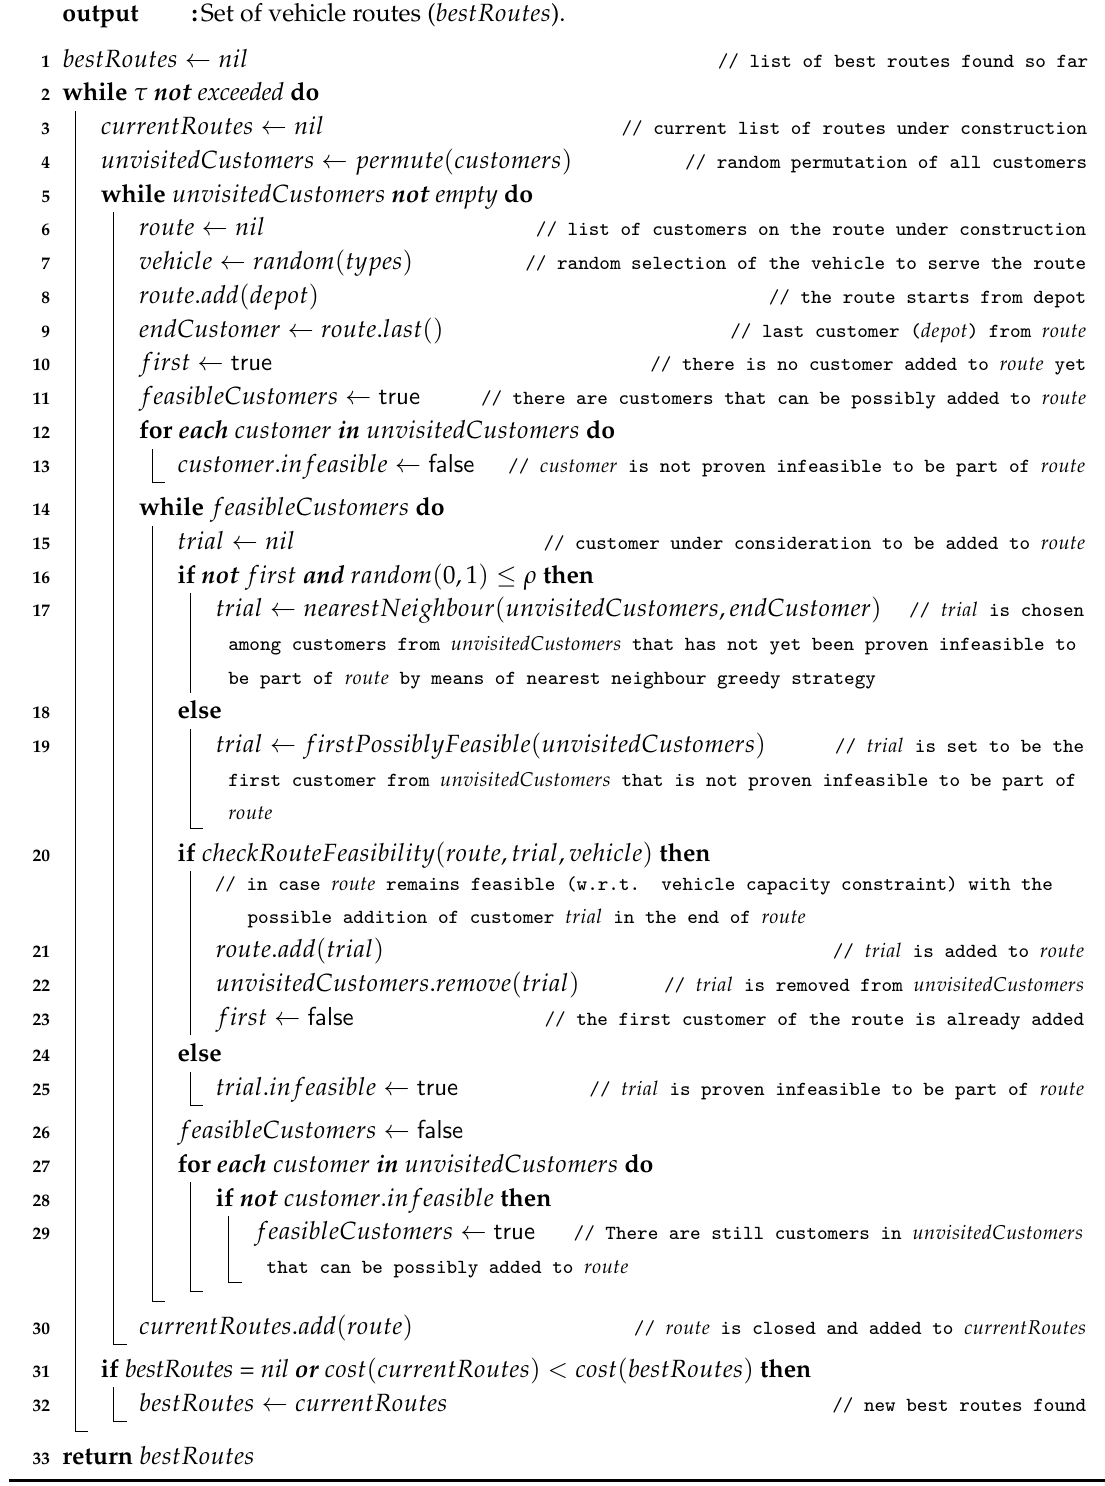
Algorithm 1: Nearest-Neighbor-Based Randomized Algorithm parameters : Computation time limit τ , probability ρ of using the nearest neighbour